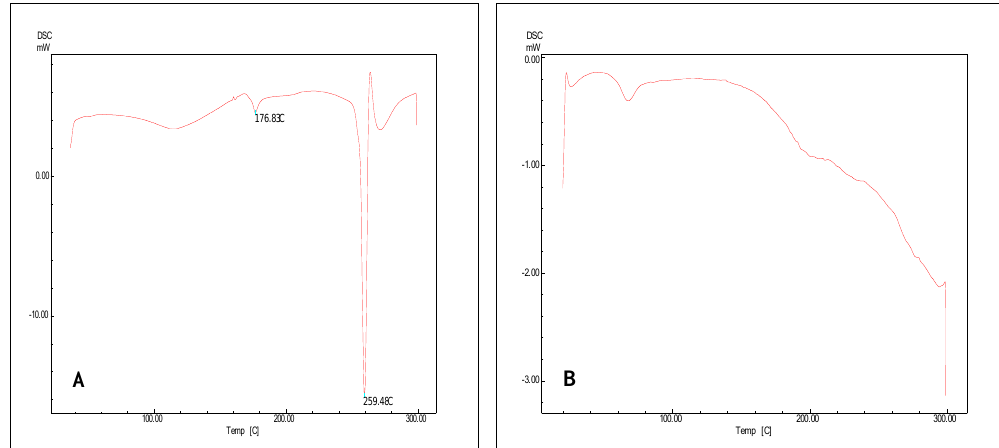
Figure 3. DSC thermograms of [A]pure ACV [B] Eudragit